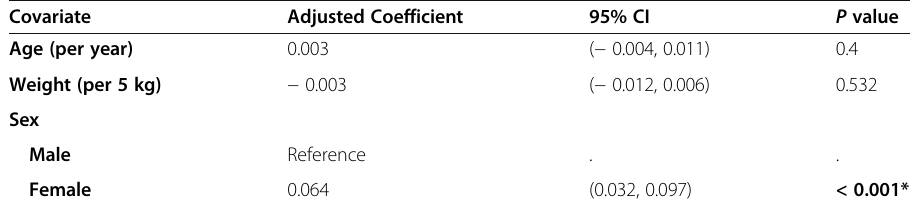
Table 4 Multivariable median regression analysis of kidney activity fraction Covariate Adjusted Coefficient 95% CI P value Age (per year) 0.003 ( − 0.004, 0.011) 0.4 Weight (per 5 kg) − 0.003 ( − 0.012, 0.006) 0.532 Sex Male Reference . . Female 0.064 (0.032, 0.097) < 0.001*